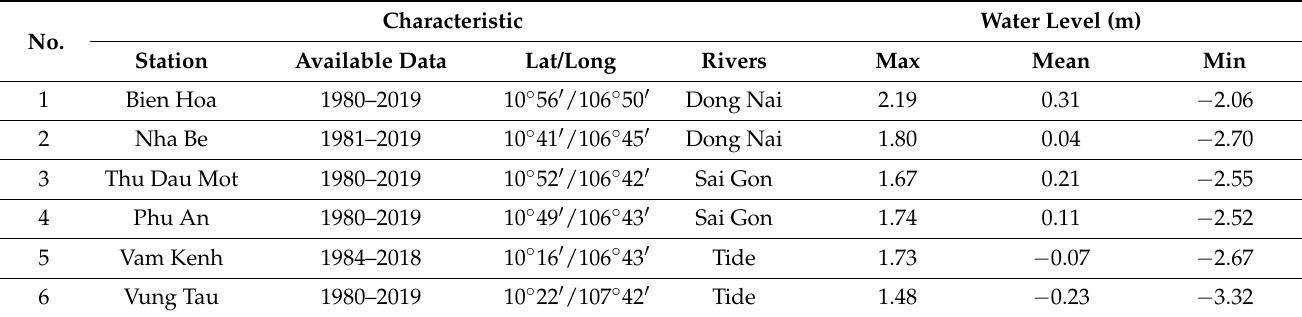
Table 1. Description of the six monitoring